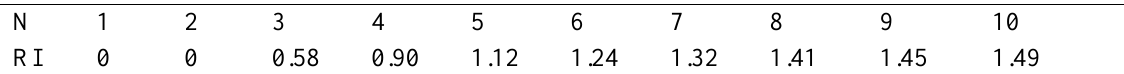
Table 2. Random Index